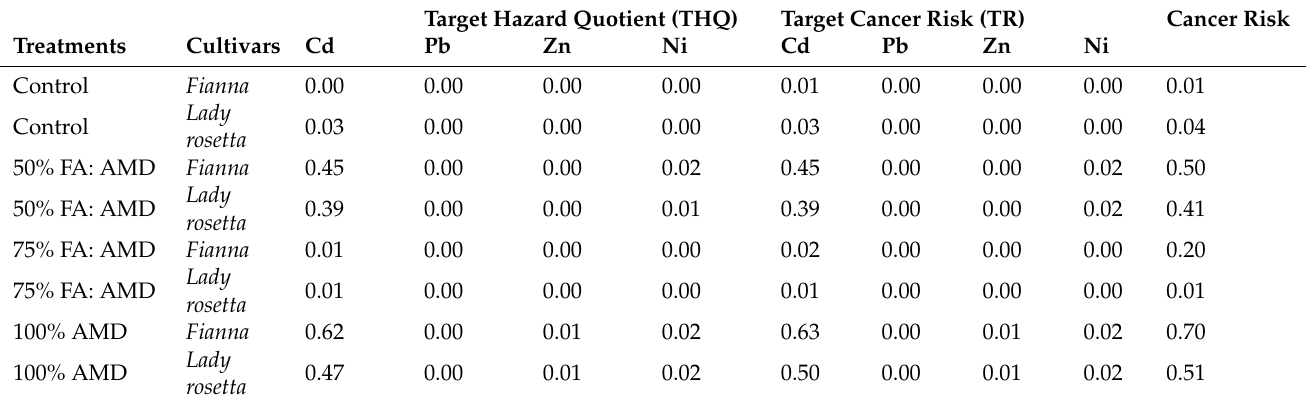
Table 4. Effect of AMD treatments on the Target Hazard Quotient (THQ), Target cancer risk (TR) and Cancer risk of two potato varieties ( Fianna and Lady rosetta ).